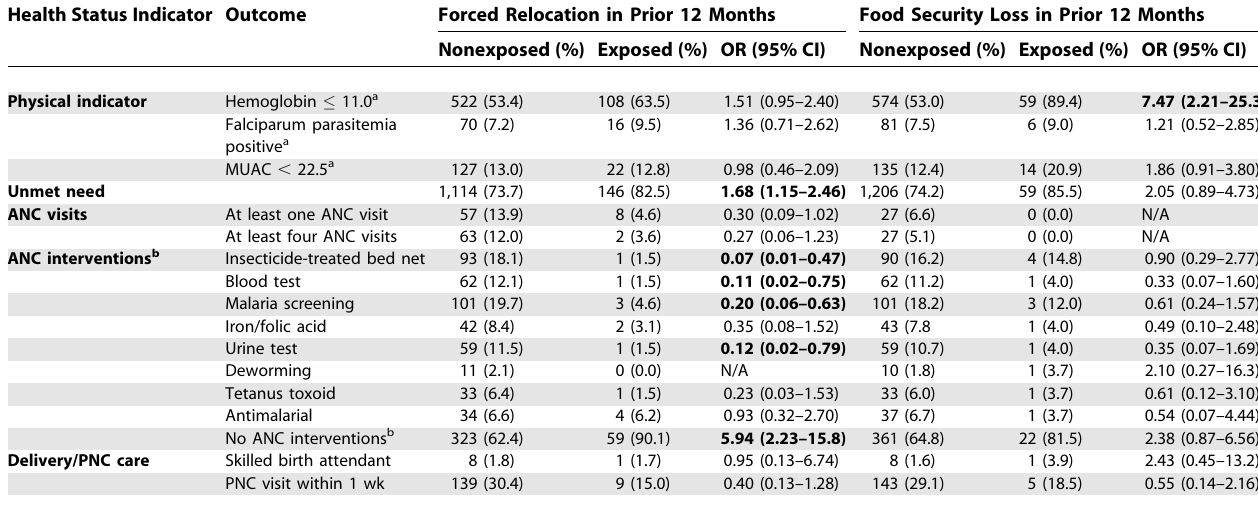
Table 4. Association between Selected Maternal Health Indicators and Access to Antenatal Interventions and Human Rights Violations among Karen